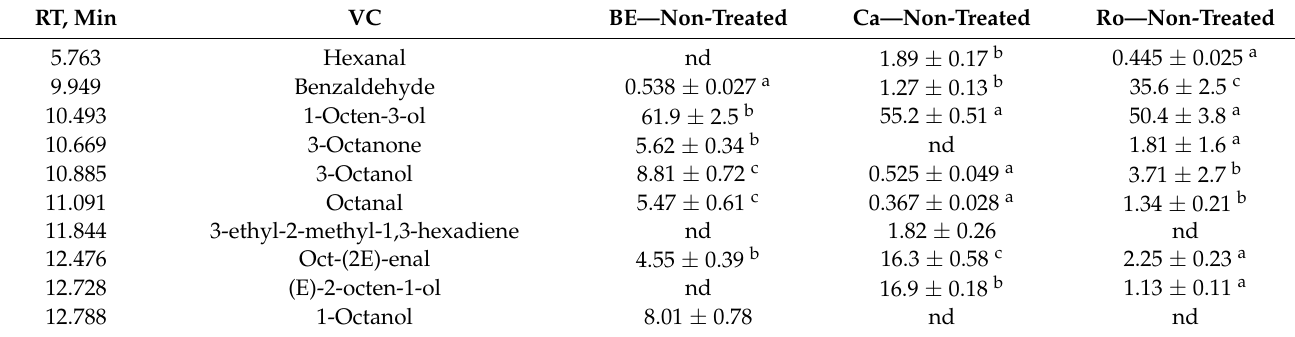
Table 2. Volatile compounds (in whole profile >1%) of non-treated mushrooms (% from the total volatile